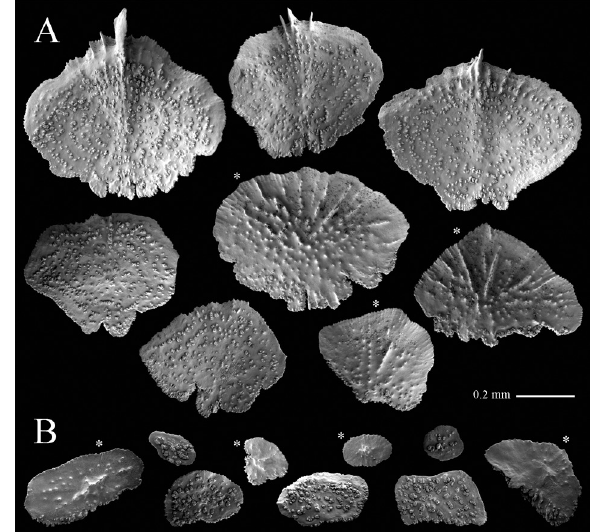
Fig . 14. – Thouarella grandiflora Kükenthal, 1912, holotype (MPUW 44): A, body scales; B, coenenchymal sclerites. [ * outer surface view].